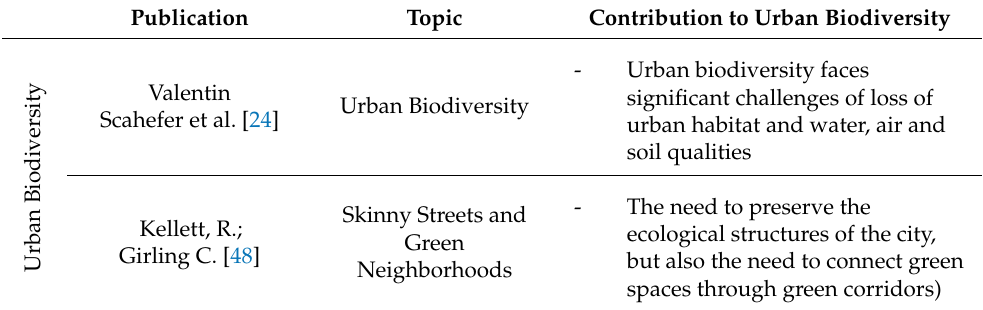
Table A5. Summary table of the contribution to urban biodiversity (developed by the